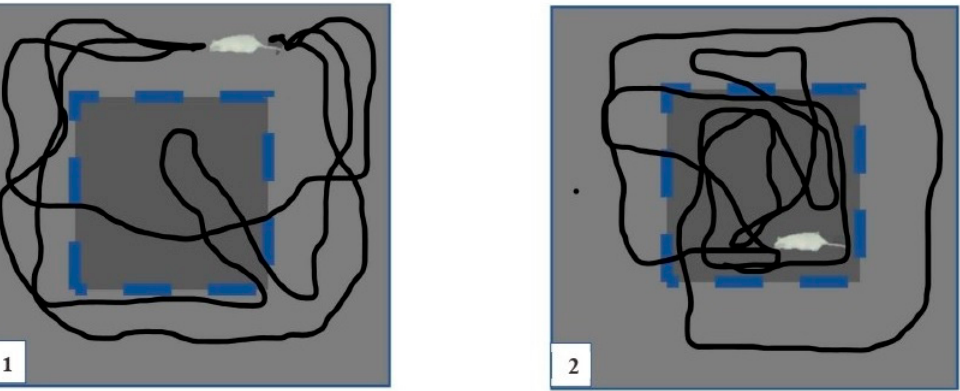
Figure 7. Rat activity in the open-field test (OFT). ( 1 ) Anxious rat’s behaviour in preference of pe- ripheral arena. ( 2 ) Normal rat’s behaviour in preference of central arena. peripheral arena. ( 2 ) Normal rat’s behaviour in preference of central